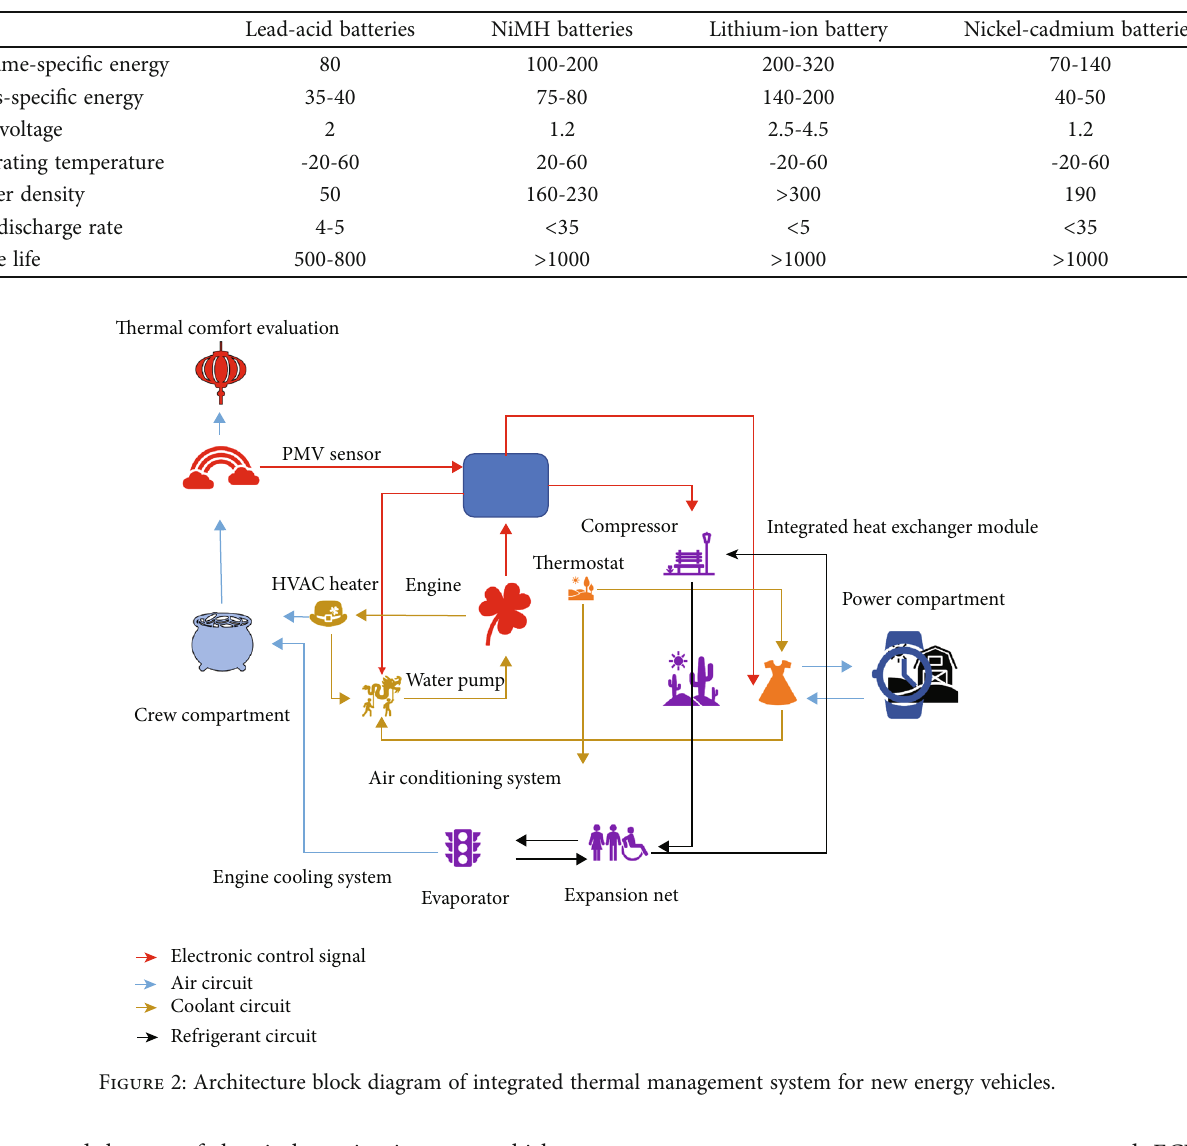
Table 2: Comparison of performance parameters of di ff erent types of power batteries.